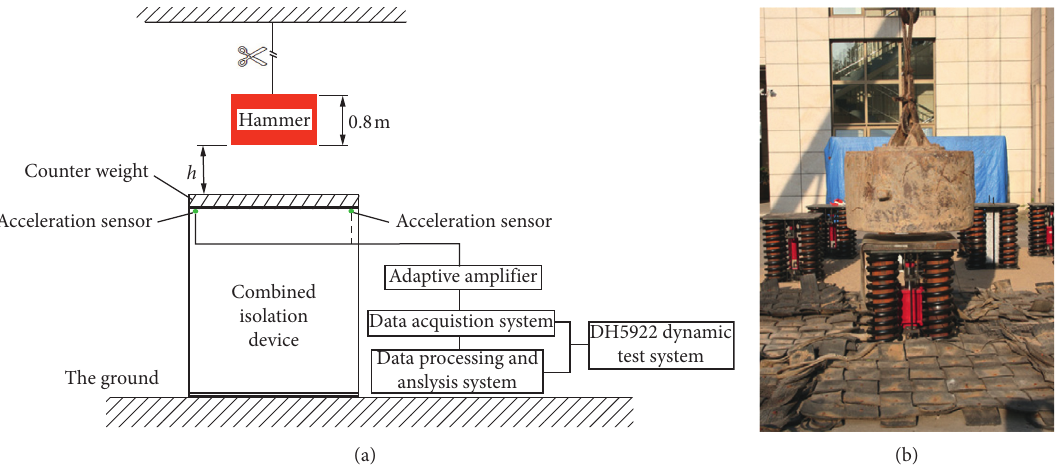
Figure 2: The diagram of experimental test. (a) Schematic diagram. (b) Actual test figure.